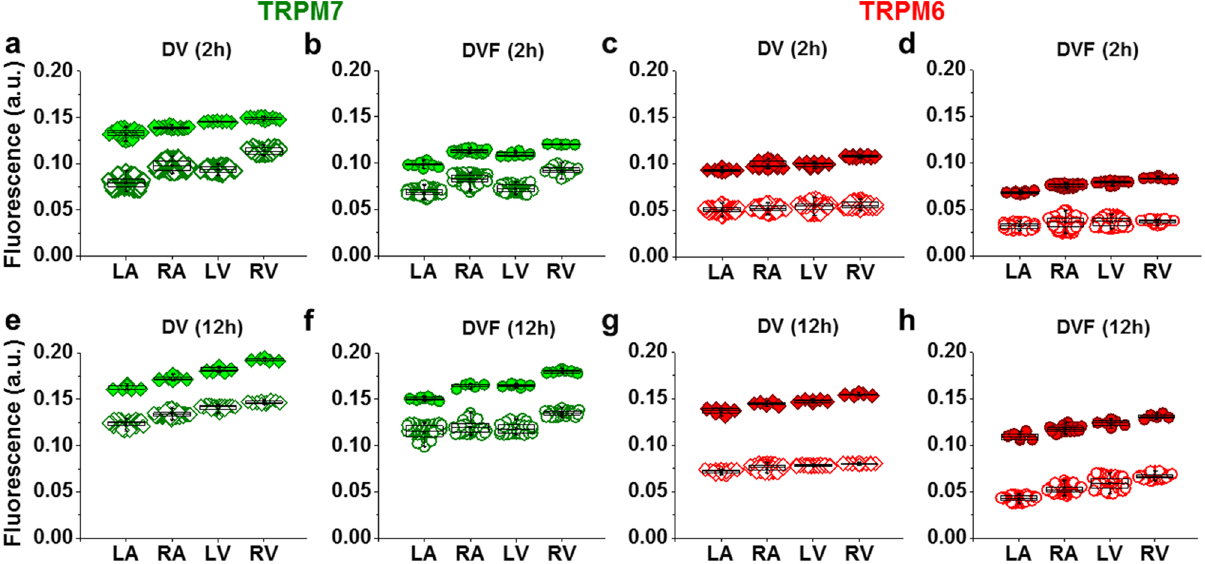
Figure 5. Comparison of the levels of TRPM6 and TRPM7 in IHD vs. non-IHD. ( a–d , e–h ) Quantification of the intensity of fluorescence in cardiomyocytes obtained from patients with IHD ( filled symbols ) and without such diagnosis ( unfilled symbols ) expressed in arbitrary units (a.u.) in presence/absence of divalent cations, 2 h and 12 h, respectively. In all cells used P < 0.001 IHD vs. non-IHD. Other notations are the same as in Fig. 1. IHD increases the fluorescence level of the immunodetected TRPM7 ( green ) and TRPM6 ( red ) proteins